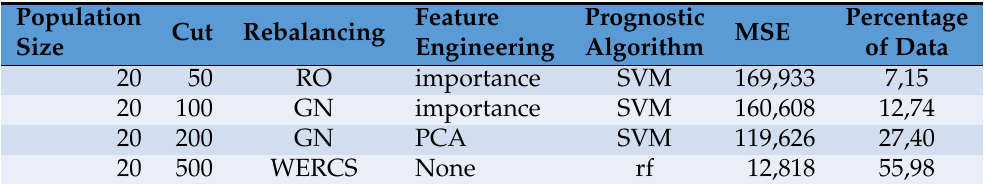
Table 16. Chosen prognostic settings and MSE for different cut settings (cut 50, 100, 200, or 500 FC before